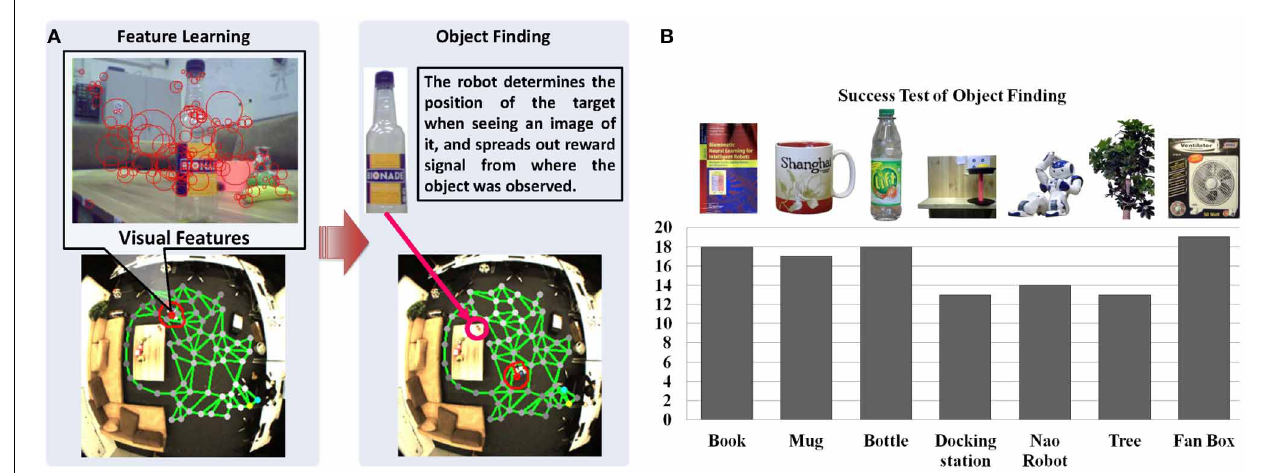
FIGURE 6 | Anchoring appearance features in the sensorimotor map. (A) Shows the features extracted from the robot’s camera during navigation. We use SURF features (Bay et al., 2006) for representing the appearance